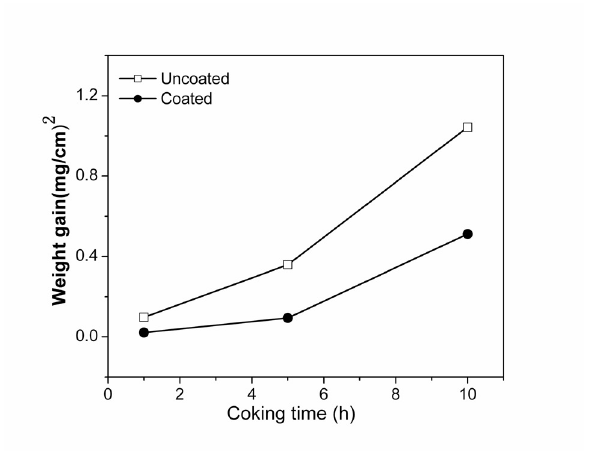
Figure 4. Weight gains of coated and uncoated HP40 steels in C 3 H 8 for 1 h, 5 h and 10